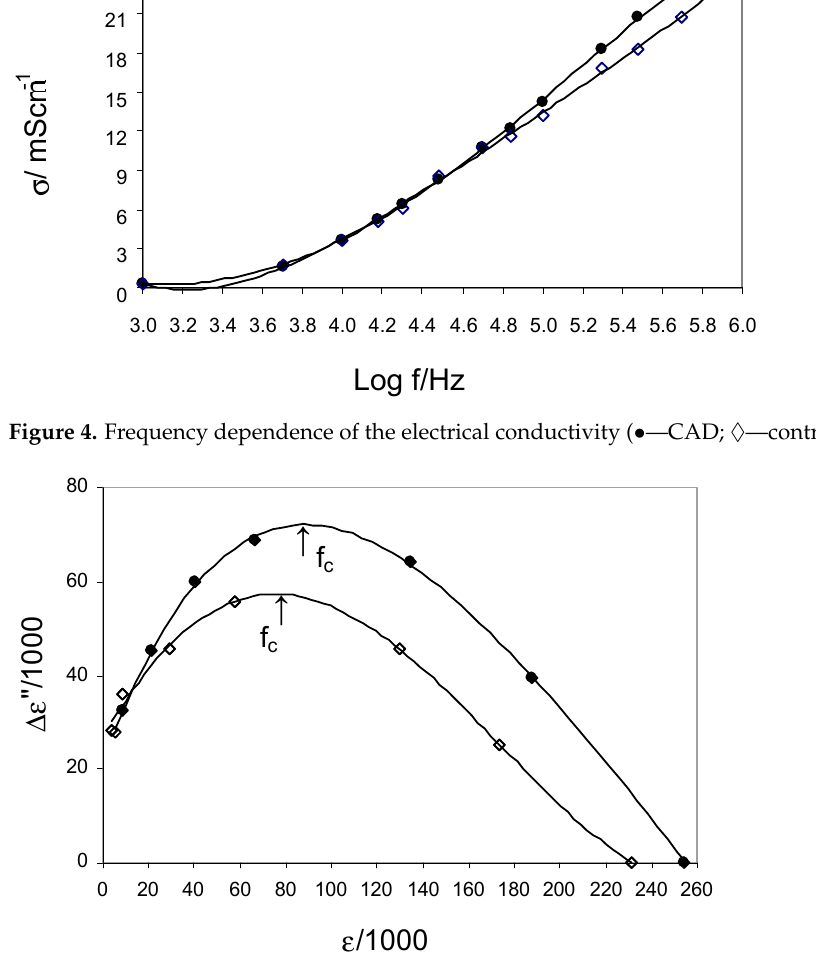
Figure 5. Cole–Cole plots of the experimental data ( ● —CAD; ◊ —control).